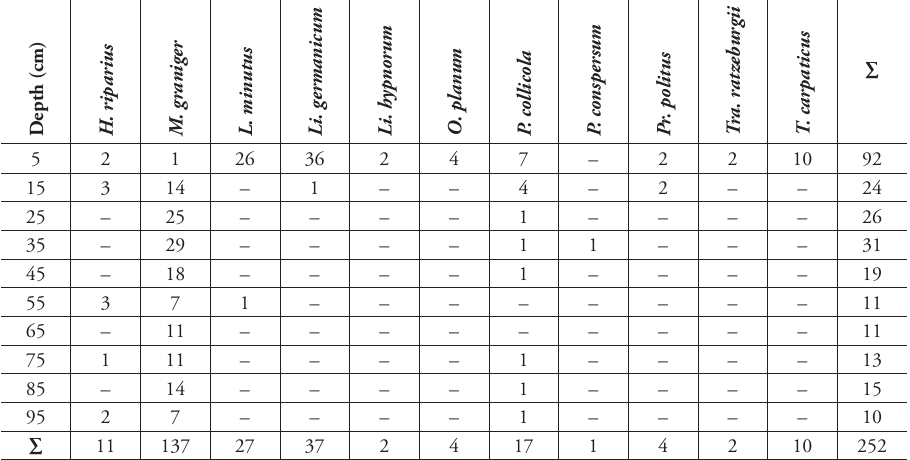
Table 3. A summary overview of the isopod depth distribution in the eight Western Carpathian scree slopes.